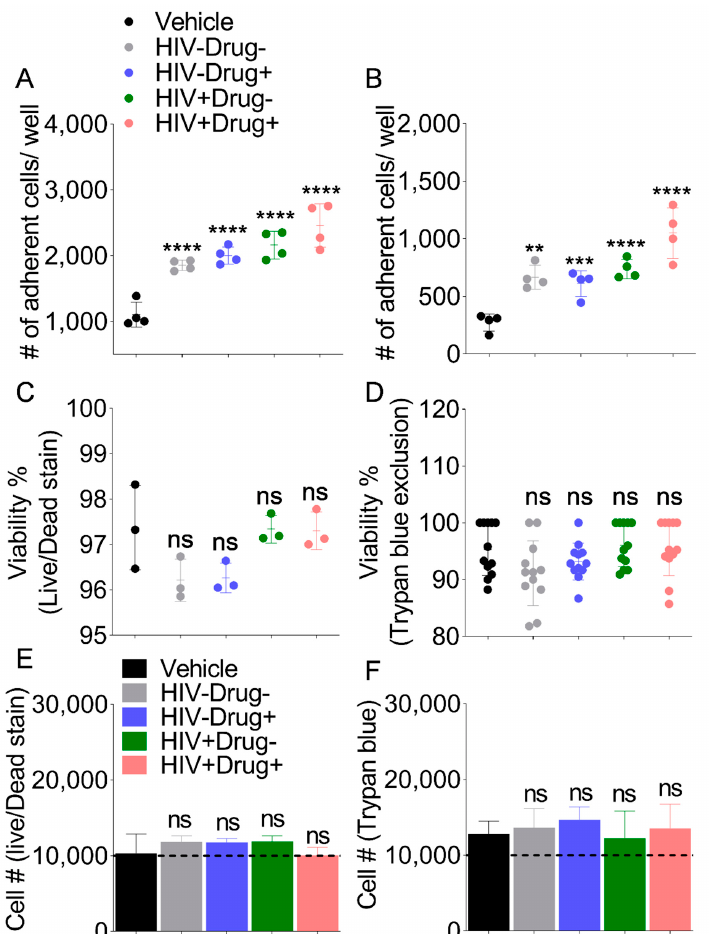
Figure 5. Monocyte adhesion to collagen is increased by SE from HIV-infected participants with comorbid psychostimulant use: 10,000 cells were treated with vehicle PBS or 100 µg/mL (~2 × 10 10 particles/mL) SE from each clinical group and cultured atop collagen coated 96 well plate for 18 h in either complete media or serum free media. Subsequently, non-adhered cells were washed three times with PBS and adhered cells were stained with NucBlue. The entire well was imaged using LionHeart FX. The total number of adhered cells was determined using Gen5 Imaging software. Quantification of adherent monocytes in complete RPMI ( A ) and serum-free RPMI ( B ). Error bars indicate standard deviation of 4 independent wells per treatment. Analysis of monocyte viability by Live/Dead Stain ( C ) and Trypan Blue exclusion ( D ). Cell proliferation as determined by counting total live cells by Live/Dead Stain ( E ) or Trypan Blue stain ( F ). Error bars indicate standard deviation of three independent wells. Ordinary one-way ANOVA test (Dunnett’s correction) was used to determine the di ff erences induced by the di ff erent SE treatments as compare to vehicle. * p < 0.05, ** p < 0.01, *** p < 0.005, **** p < 0.001, and ns,